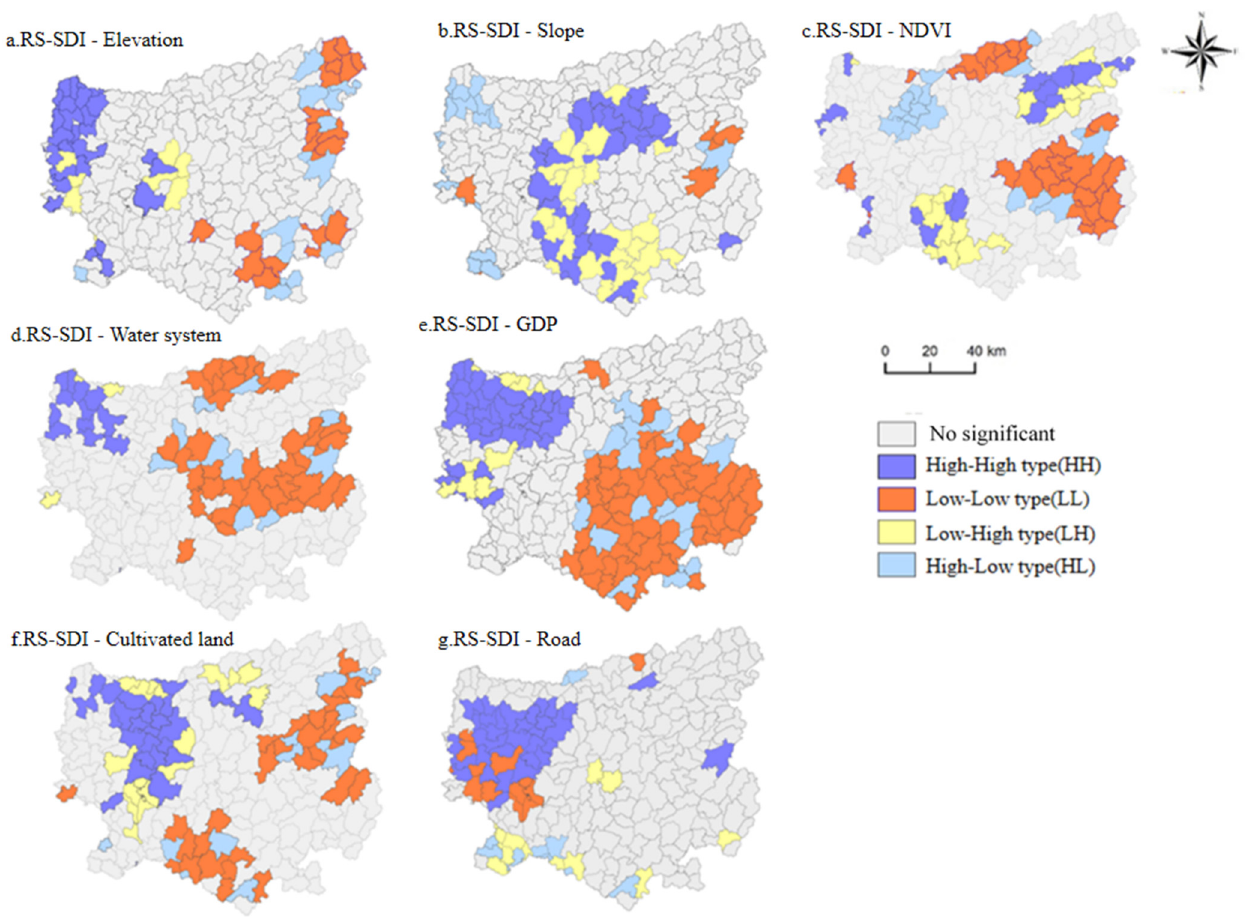
Figure 6. Spatially localised spatial correlation aggregation map of the rural sustainable development levels and influencing factors. (Note: Figures ( a – d ) show the relationship between RS-SDI and natural environmental factors; ( e – g ) show the relationship between RS-SDI and socio-economic fac- tors.)